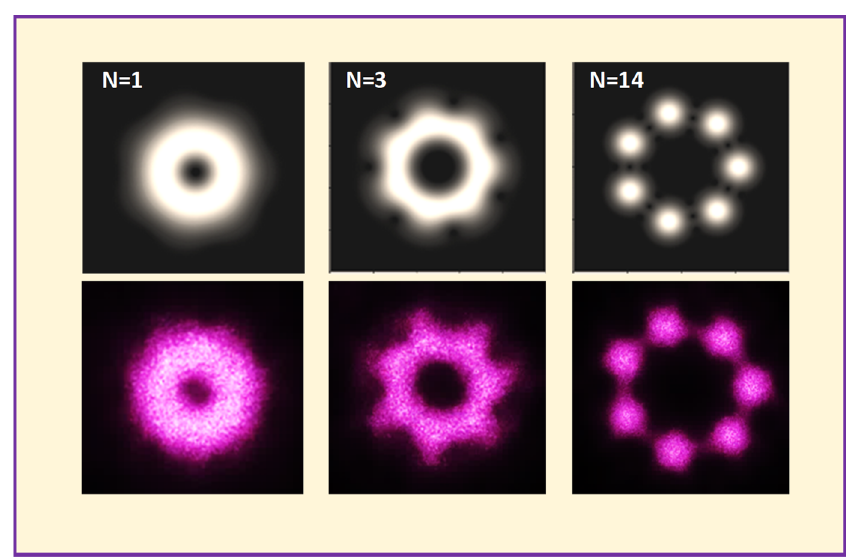
on the flat mirror, corresponding to the nonplanar geometric modes shown in Figure 3.